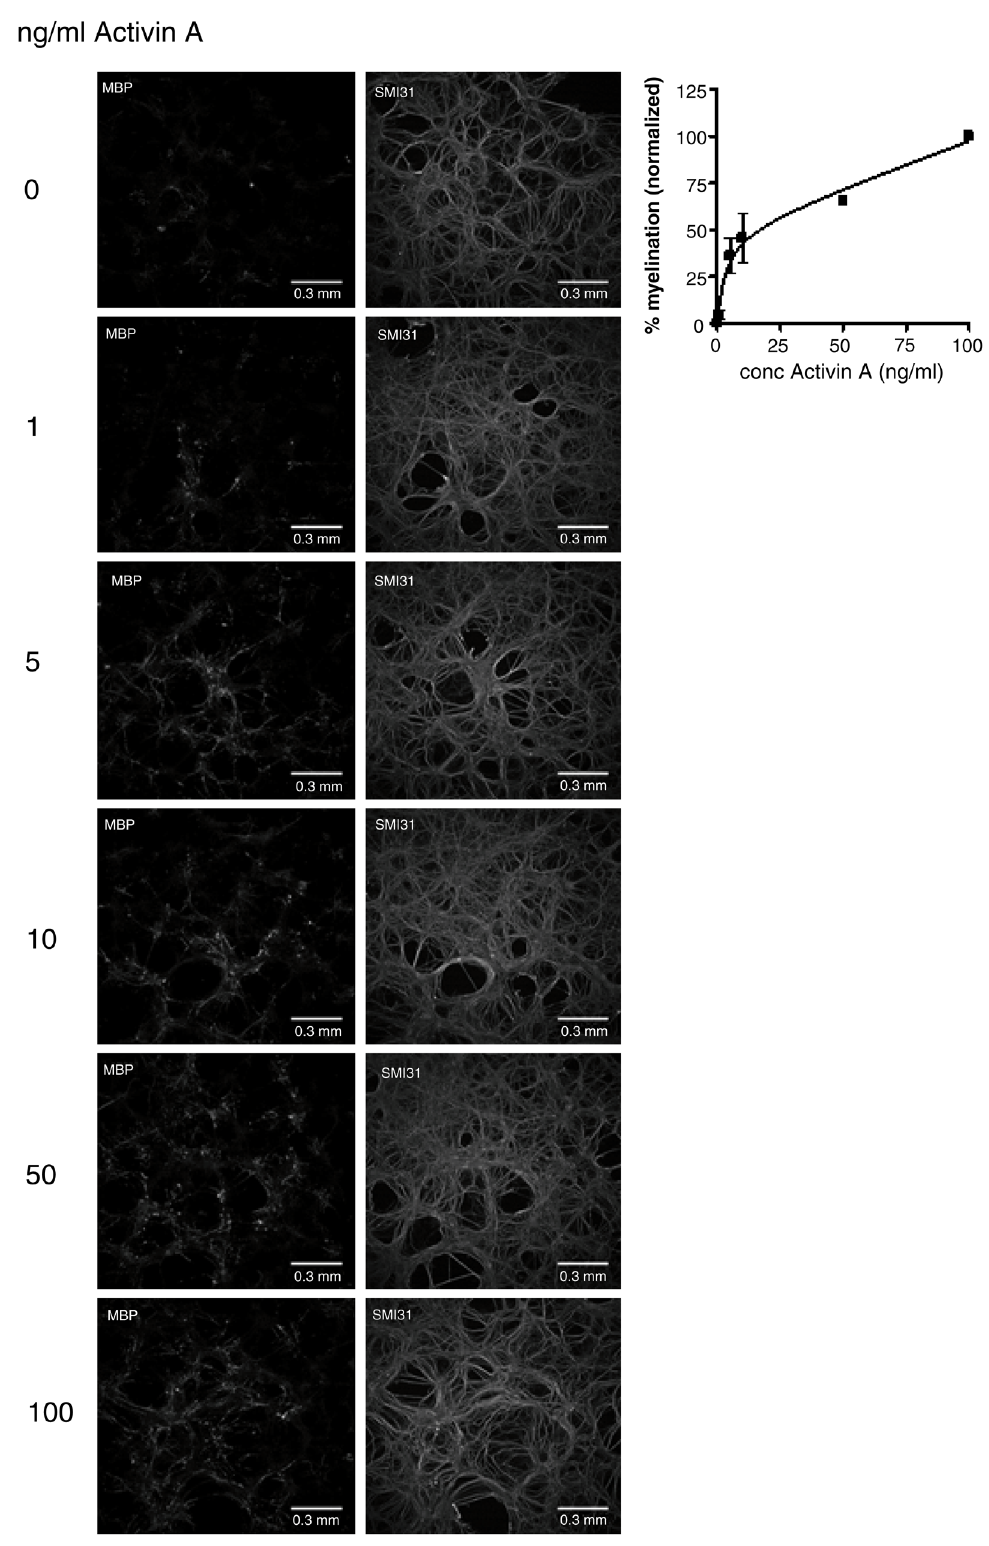
Figure 7. Microplate assays are sensitive to small changes in myelination. Spnal cord cultures were treated with increasing doses of Activin-A. A . Representative immunofluorescence images of 96-well microplate myelinating cultures (28 DIV) stained for MBP and phosphorylated neurofilament (SMI31). B . Dose-response curve for myelination in response to Activin-A treatment. Average values from 2 independent cultures, 5 technical repeats per culture, +/- s.e.m.